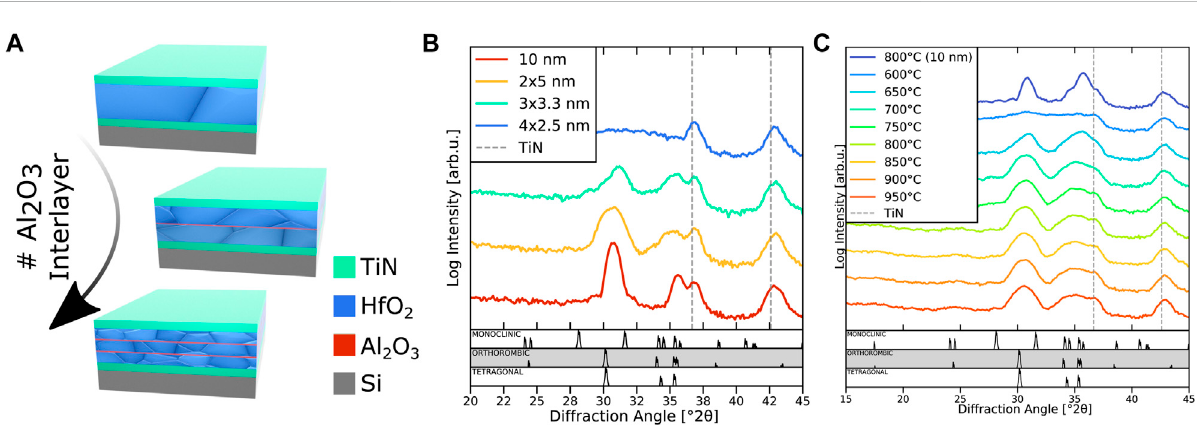
FIGURE 1 Structural analysis of doped HfO 2 -Al 2 O 3 heterostructures. (A) Schematic illustration of the heterostructure in dependence of the number of Al 2 O 3 interlayers. GIXRD patterns for HZO/Al 2 O 3 heterostructures are presented in (B) , showing a decrease of intensity of the diffraction line at 30 ° . The patterns collected for 2 × 5 nm HSO samples (C) indicate a crystallization between the annealing temperatures of 600 and 650 ° C. Wider diffraction lines are observed compared to the 10 nm HSO reference.